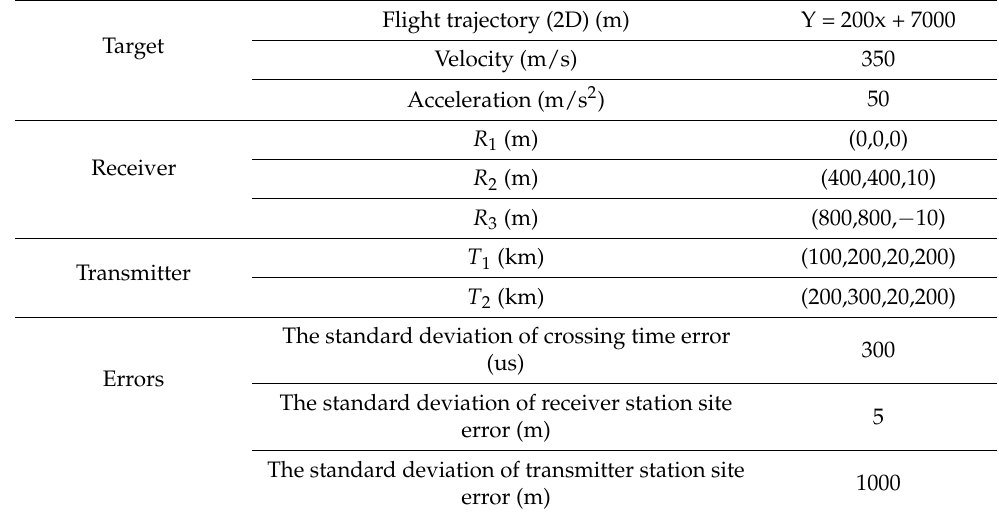
Table 3. Simulation parameter